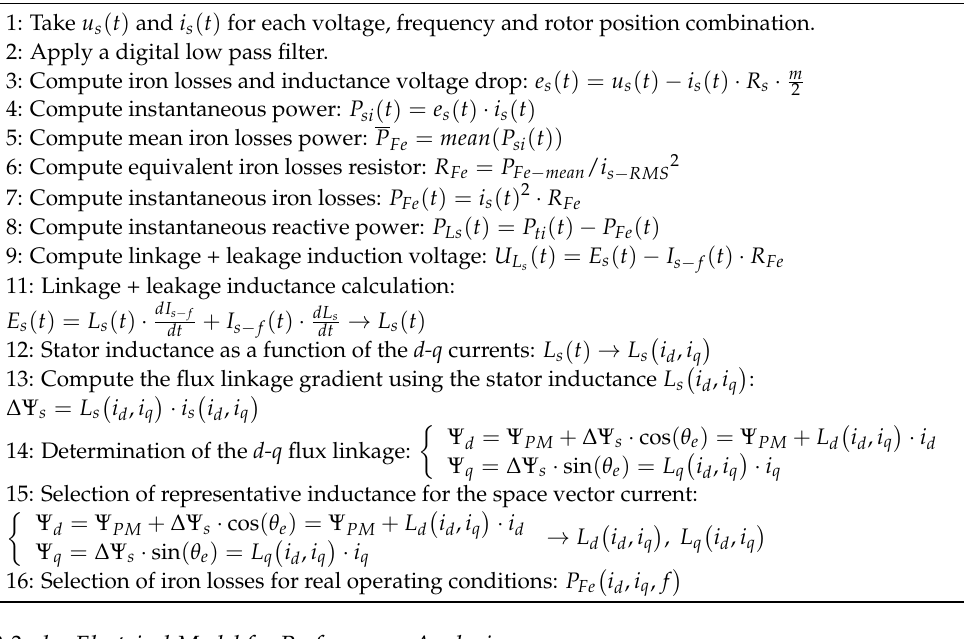
Algorithm 1. Parameter analysis extraction